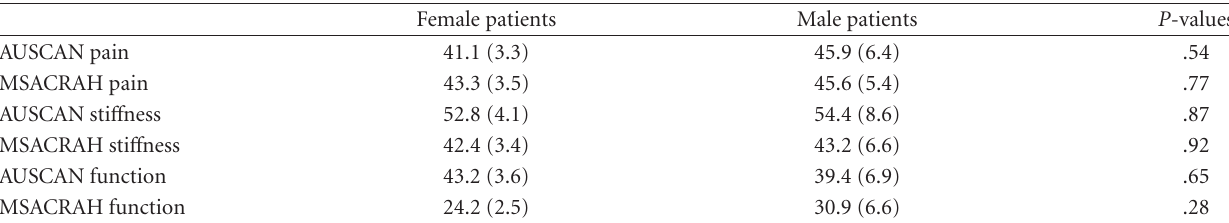
Table 3: Gender di ff erences of the single domains.